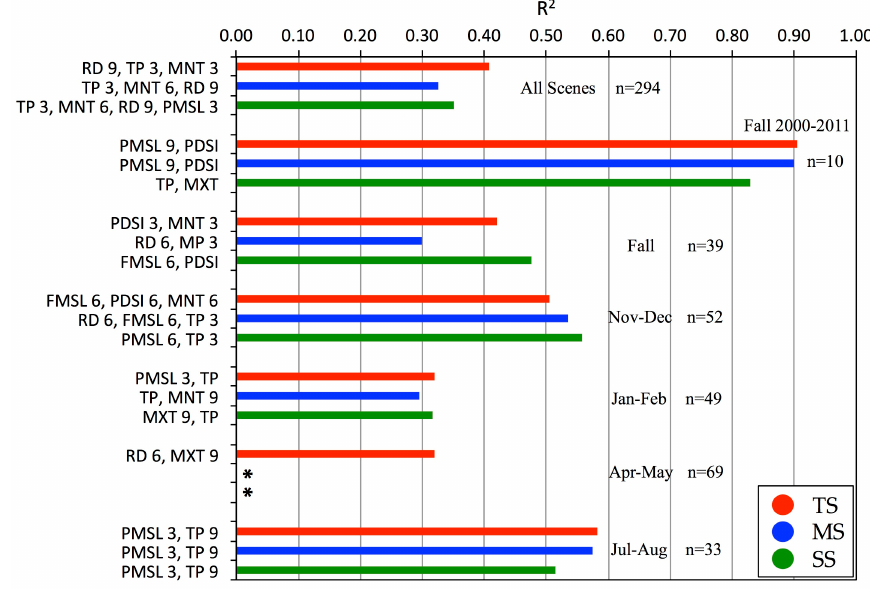
Figure 7. Multivariate analysis results for tall (TS), medium (MS), and short (SS) S. alterniflora versus abiotic drivers across each of the seven-binned periods. Driver abbreviations: Altamaha River Discharge (RD), Ft. Pulaski Mean Sea Level (PMSL), Fernandina Beach Mean Sea Level (FMSL), Palmer Drought Severity Index (PDSI), Total and Mean Precipitation (TP and MP), and Maximum and Minimum Temperature (MXT and MNT). * Unable to identify best multivariate model due to collinearity among variables.